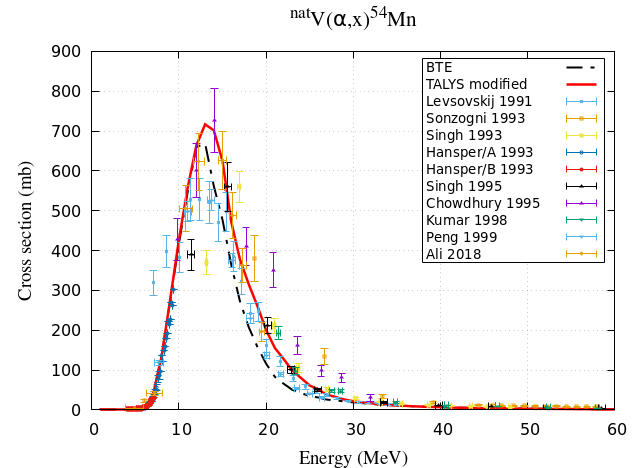
Fig. 2. Experimental and theoretical (BTE and TALYS modified) cross sections for the reaction Nat V(α,x) 54